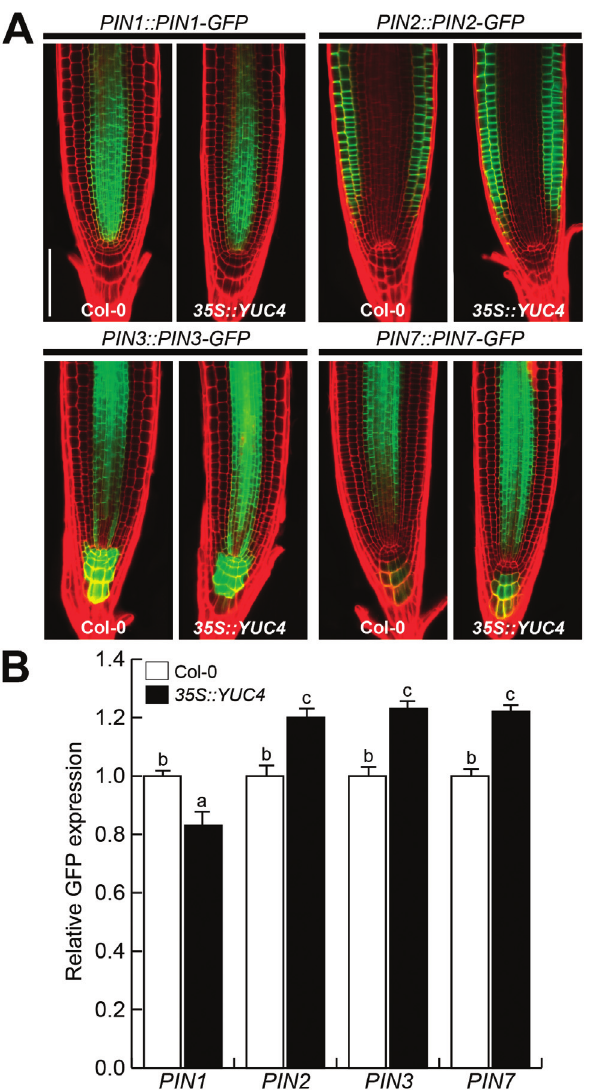
Figure 4 - NPA decreases hypocotyl length in 35S::YUC4 seedlings. (A) WT (Col-0) and 35S::YUC4 seedlings were germinated and grown in MS 0.2X media supplemented with different NPA concentrations, representa- tive images of control, 2 and 8 (cid:2) M of NPA are shown. Bar = 1 mm. (B) Mean hypocotyl length. Error bars represent standard error from 30 seed- lings analyzed. Different letters indicate means that are statistically differ- ent ( P < 0.05 ). The experiment was repeated three times with similar re-